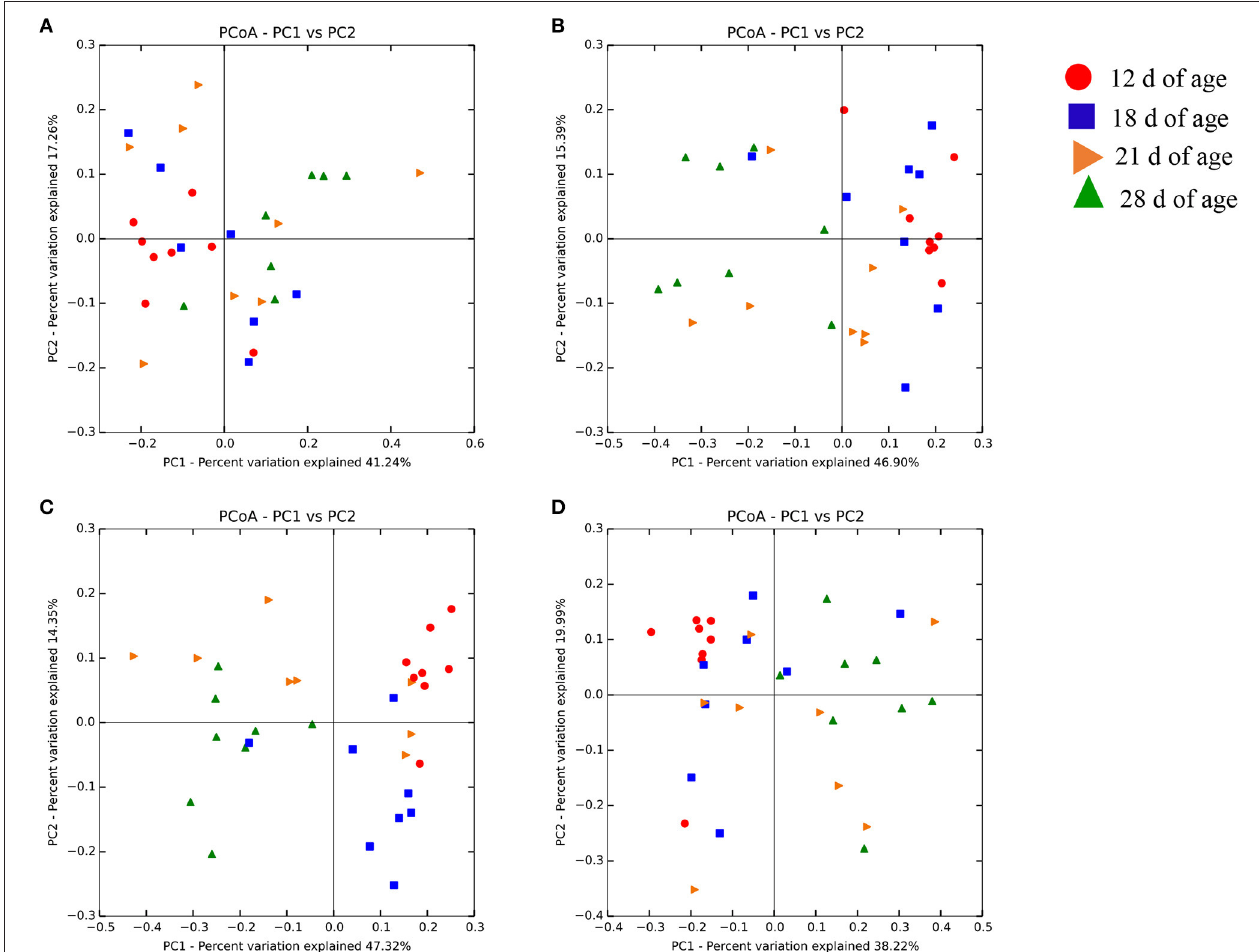
FIGURE 1 | Weighted UniFrac PCoA of the cecal microbiota in the unchallenged control (A) , challenged control (B) , challenged and supplemented with sodium butyrate (C) , and challenged and supplemented with sodium butyrate plus essential oils (D) according to the different moments of sample